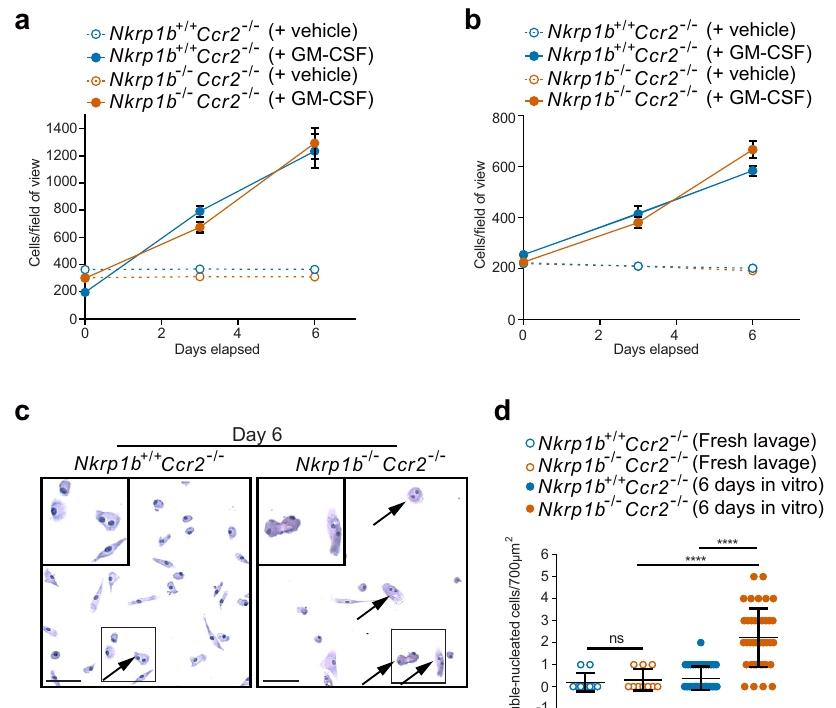
Fig. 4 | Nkrp1b − / − AMshowsignsofcellcyclede fi ciencyinvivo,but notin vitro. a and b Quanti fi cation of a number of visible cells per fi eld of view taken from Nkrp1b +/+ Ccr2 − / − and Nkrp1b − / − Ccr2 − / − miceat2and6weeksofage,respectively( n =4 mice per treatment group ofeach age). Cell numberswere quanti fi ed on days 0,3, and 6 post-plating. Data presented as mean±SEM. c Images of AM isolated from Nkrp1b +/+ Ccr2 − / − and Nkrp1b − / − Ccr2 − / − mice after being kept in vitro for 6 days andstainedwithhematoxylin. Nkrp1b − / − Ccr2 − / − framehighlightingdoublenucleated cells (arrows). Select cells within inset boxes are shown magni fi ed in the top left